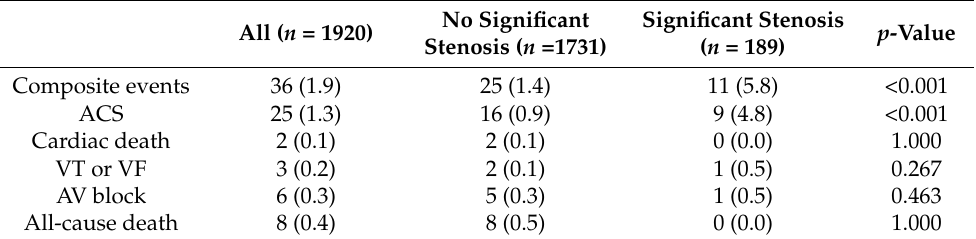
Table 2. One-year clinical event rate for patients with VA according to significant stenosis of coronary